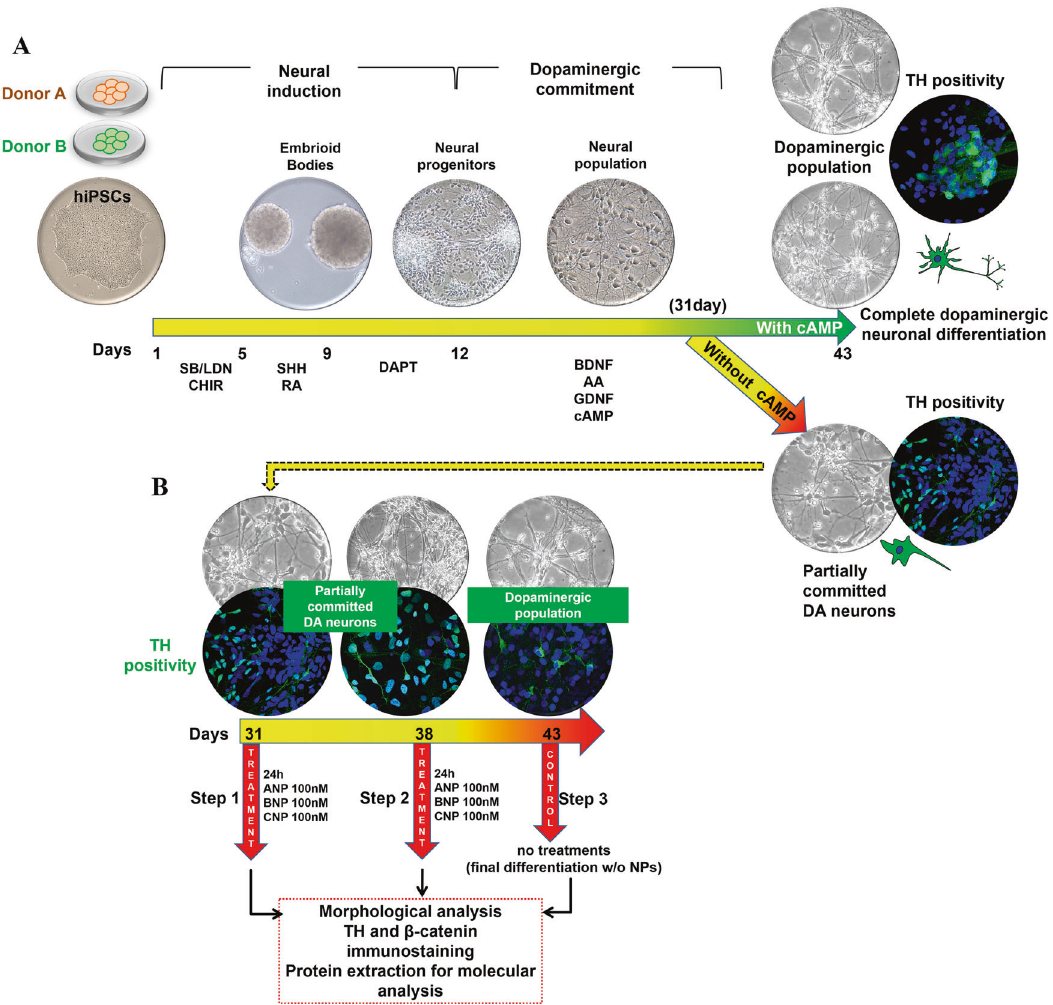
Fig. 5 Representative scheme illustrating the generation of committed DA neuron from hiPSCs, the DA neuronal differentiation by NPs treatments, and the analyses performed. A hiPSCs obtained from two different healthy donors (Donor A and Donor B) were used. Neural induction (day 1 – 12) and dopaminergic commitment (day 12 – 30) have been obtained as previously reported [59], and described in the Materials and Methods section. Complete dopaminergic neuronal differentiation was reached at day 43 of culture in presence of cAMP. B At day 30, partially committed DA populations from both donors A and B were maintained in cAMP-free culture medium and treated, at day 31 (Step 1, analyzed at day 32) or at day 38 (Step 2, analyzed at day 39), for 24 h with 100 nM of NPs. The NPs treatments have been performed at day 31 or at day 38 for assessing if the effects produced could be dependent on the state of intrinsic differentiation of the committed neurons. Cultures maintained in cAMP- and NPs-free culture medium from day 30 to day 43 (Step 3) was used as control of cells grown in absence of factors inducing DA neuronal